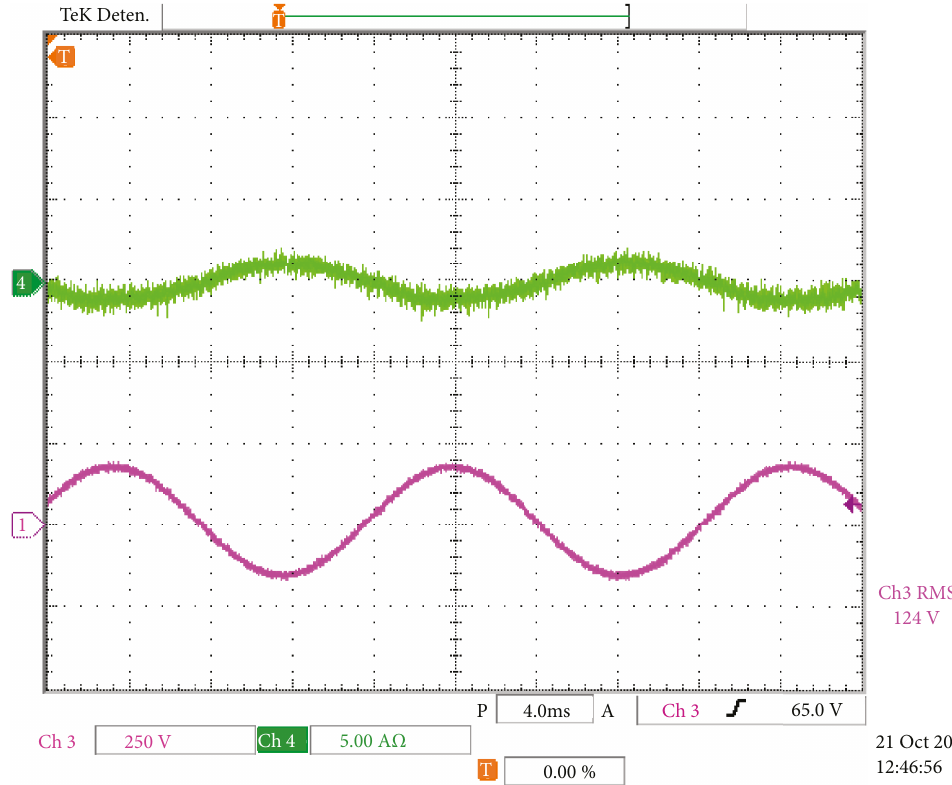
Figure 9: Experimental results when the topology only injects the active power. From top to bottom: grid current (5 A/div) and grid voltage